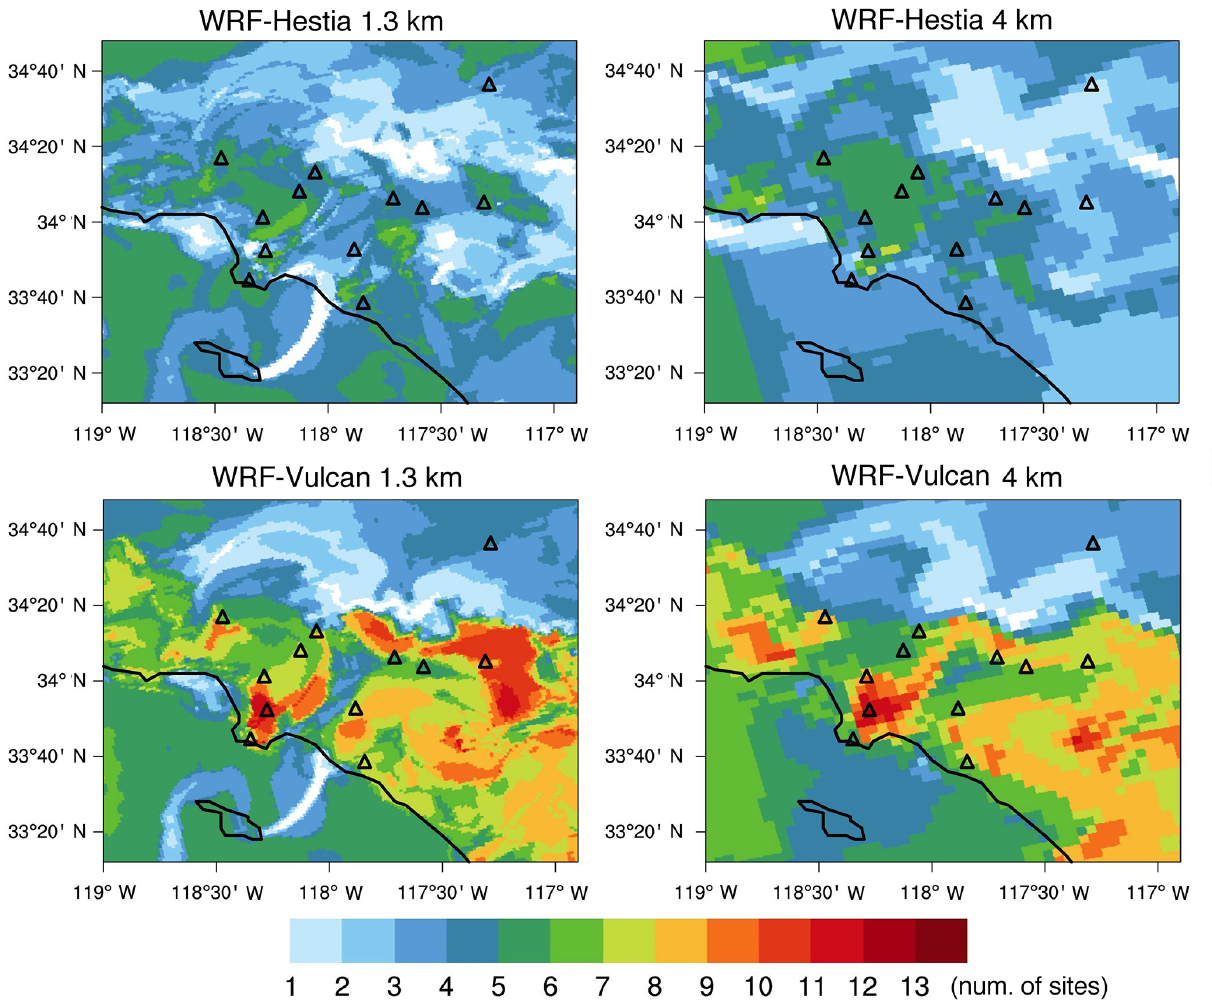
Figure 14. Composite maps of spatial correlation ( R in Figs. 12 and 13) for the 1.3km WRF-Hestia, 1.3km WRF-Vulcan, 4km WRF-Hestia, and 4km WRF-Vulcan runs. Each composite map was constructed by determining the number of the observation sites for which | R | is greater than 0.46 at each grid cell. | R | = 0 . 46 is the critical value at the significance level of 0.01 of t test. Specifically, white cells indicate that no sites are correlated well at the location; dark red cells indicate that over 13 sites have good correlation at the location. The SCI and Dryden sites are not shown on these